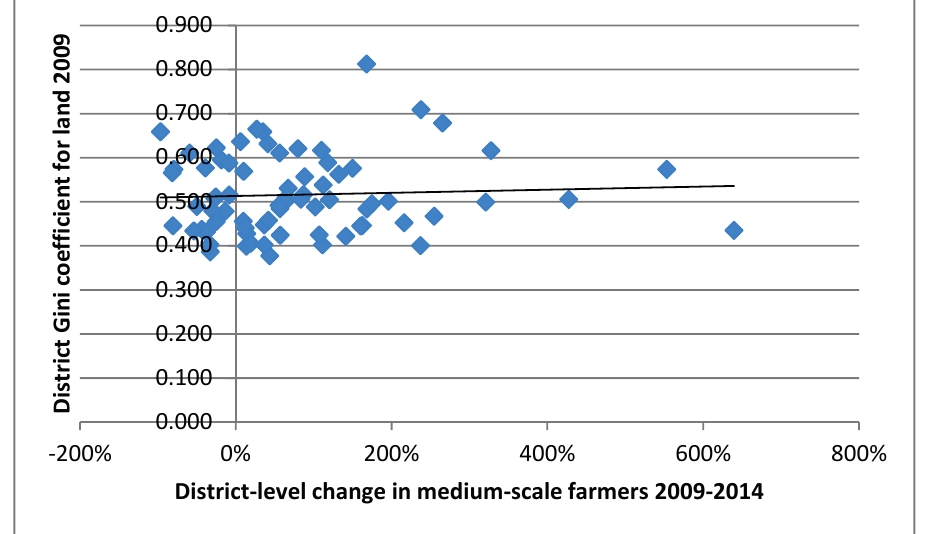
Figure 4. Scatter plot of District-level land Gini Coefficients by Changes in the Share of Medium-Scale Farms to Total Smallholder Population. Source: CFS Various